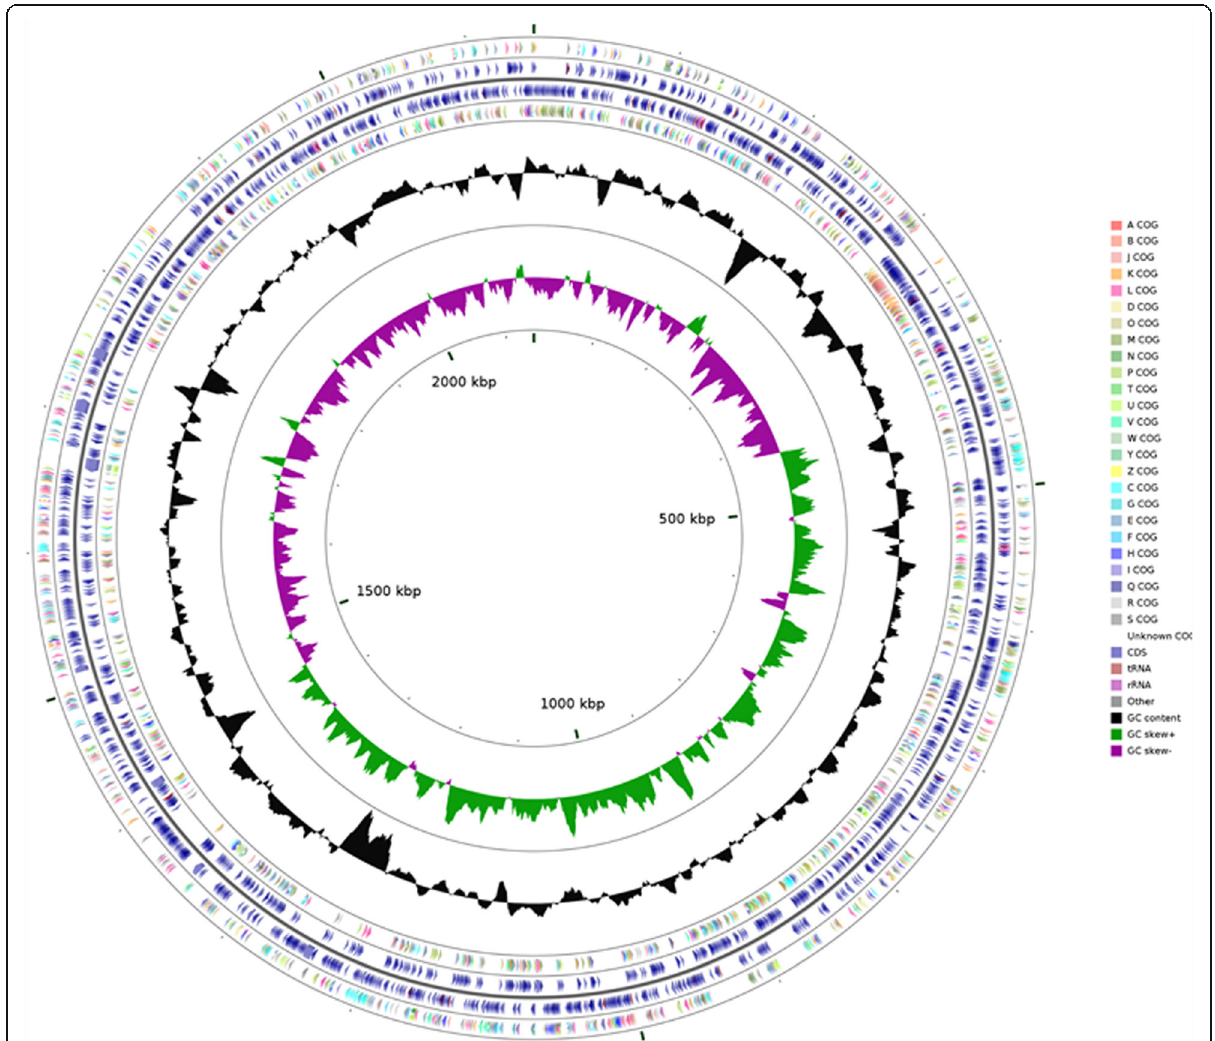
Fig. 3 Circular map of N. lactamica Y92 – 1009 genome and features generated with Cgview Comparison Tool. The arrows in the outermost ring indicate putative genes (with the arrow indicating the 5 ′ to 3 ′ direction on the positive strand.) identified and assigned to Clusters of Orthologous Groups (COGs). The 20 COG categories are indicated by different colours from Red to Grey according to the colour key. The second and third rings indicate regions containing coding sequence ( Blue ), tRNA (Orange), and other RNAs ( Grey ), with the second ring running 5 ′ to 3 ′ (positive strand) and the third ring running 3 ′ to 5 ′ (negative strand). The fourth ring indicates open reading frames assigned as COGs and encoded on the negative strand. The fifth, black, graph ring displays GC content while the last ring ( purple and green ) shows positive ( Green ) and negative ( Purple ) GC